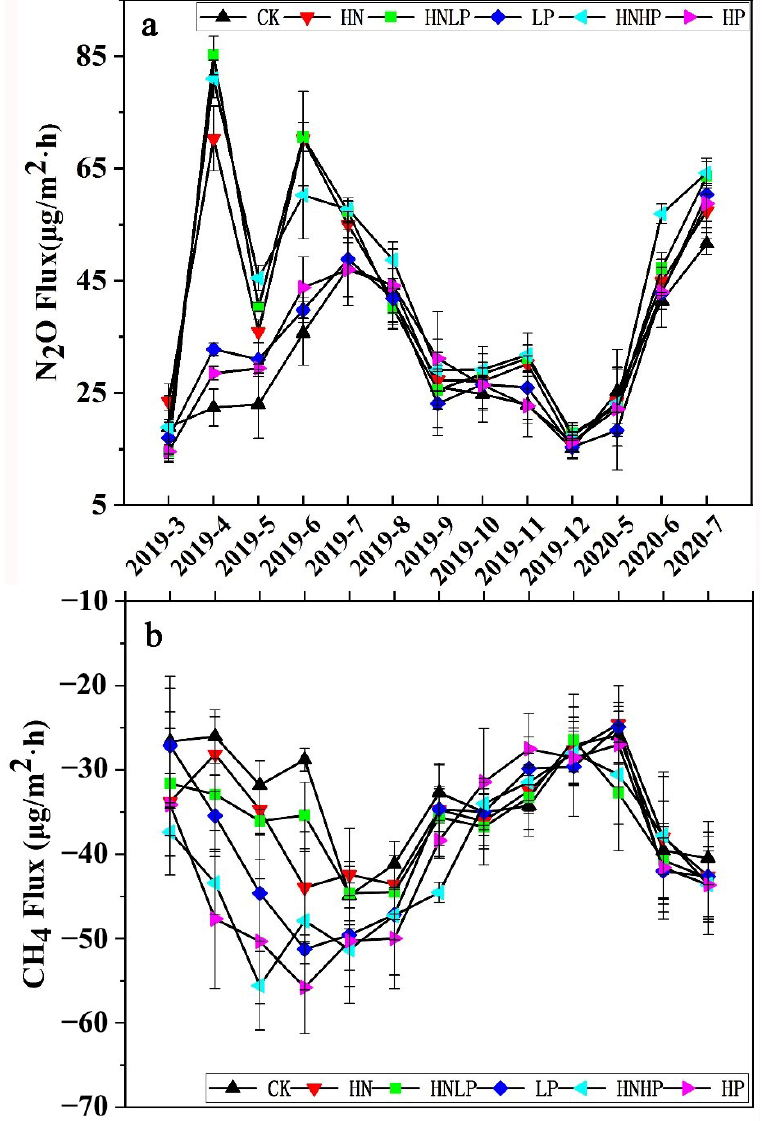
Figure 3. Monthly dynamics of soil N 2 O (( a ); µ g · N 2 O/m 2 · h) and CH 4 (( b ); µ g · CH 4 /m 2 · h) fluxes under different treatments. Error bars represent standard deviations of mean CH 4 and N 2 O fluxes ( n = 4). Table 2. Average N 2 O emissions and CH 4 uptakes in a subtropical Chinese fir plantation over the first 4 months and the entire study period. Different letters denote significant ( p < 0.05) differences between treatments.